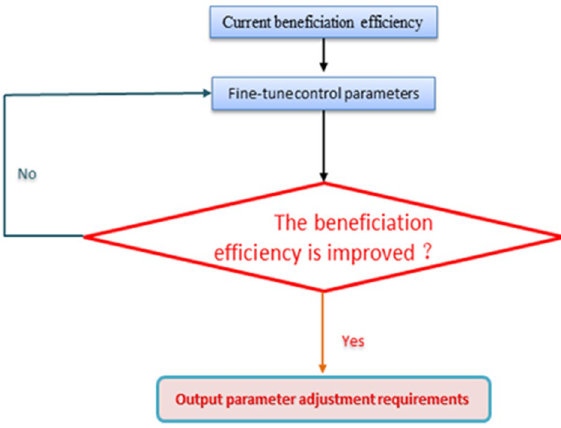
Figure 14. The principle of progressive optimization.